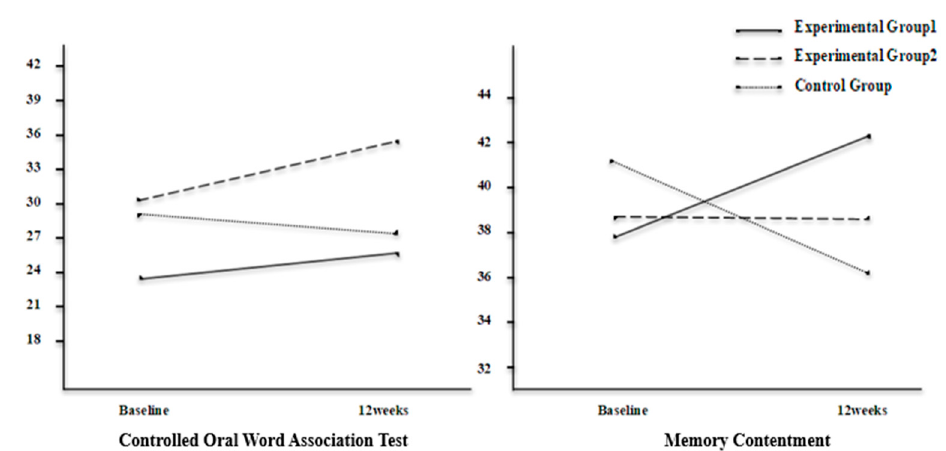
Figure 2. Interaction effects in cognitive function.